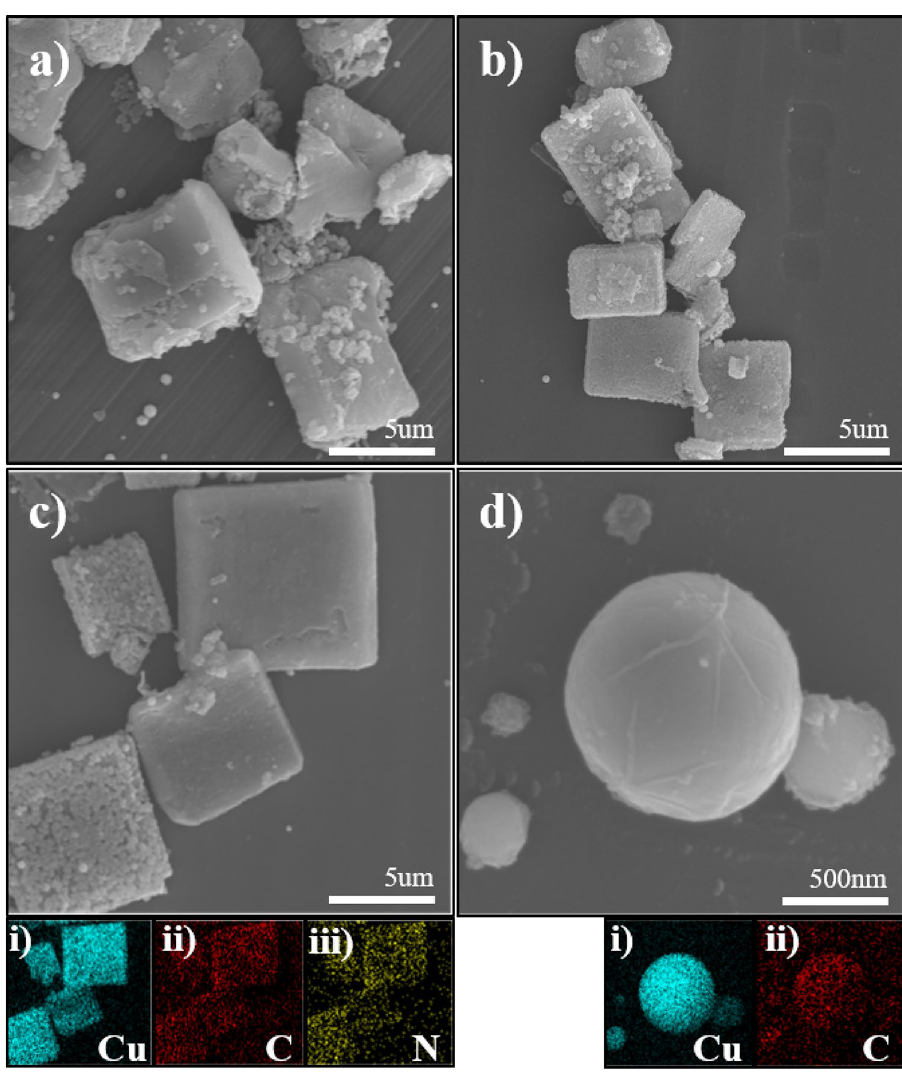
Figure 4. SEM images of samples prepared by PLA of a Cu plate in acetonitrile at ( a ) 355, ( b ) 532, ( c ) 1064 nm, and ( d ) spherical Cu NPs covered with carbon shells present in all of the above samples. EDS analysis of ( c , i–iii) cubic species and ( d , i–ii) spherical